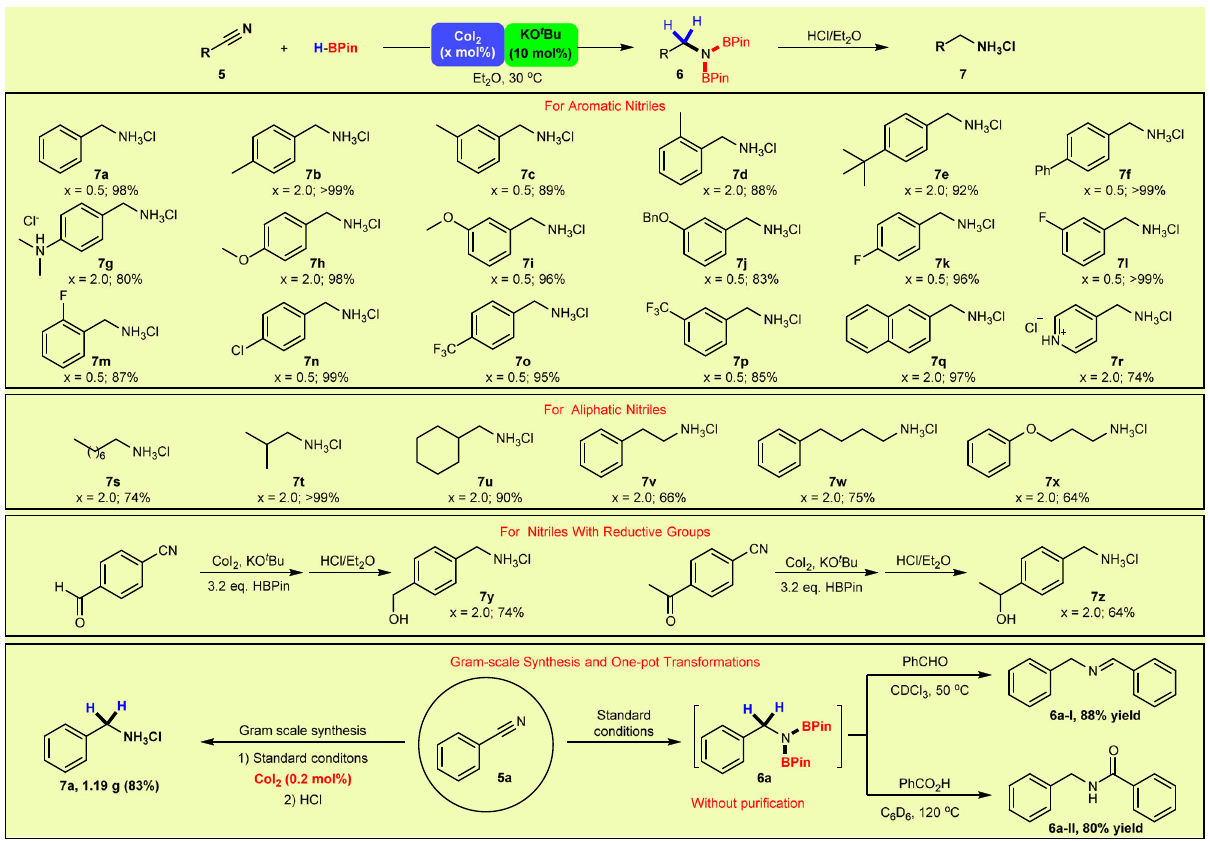
Fig. 4 CoI 2 /KO t Bu catalyzed dihydroboration of nitriles. Reaction conditions: HBPin (2.2 mmol) was added to a mixture of CoI 2 (0.5 – 2.0 mol%), KO t Bu (0.1 mmol, 10 mol%) and 5 (1.0 mmol) in anhydrous Et 2 O (2 mL), and the reaction mixture was stirred under N 2 at 30 °C for 4.0 – 24.0h. Isolated yield of the corresponding ammonium salt is shown.